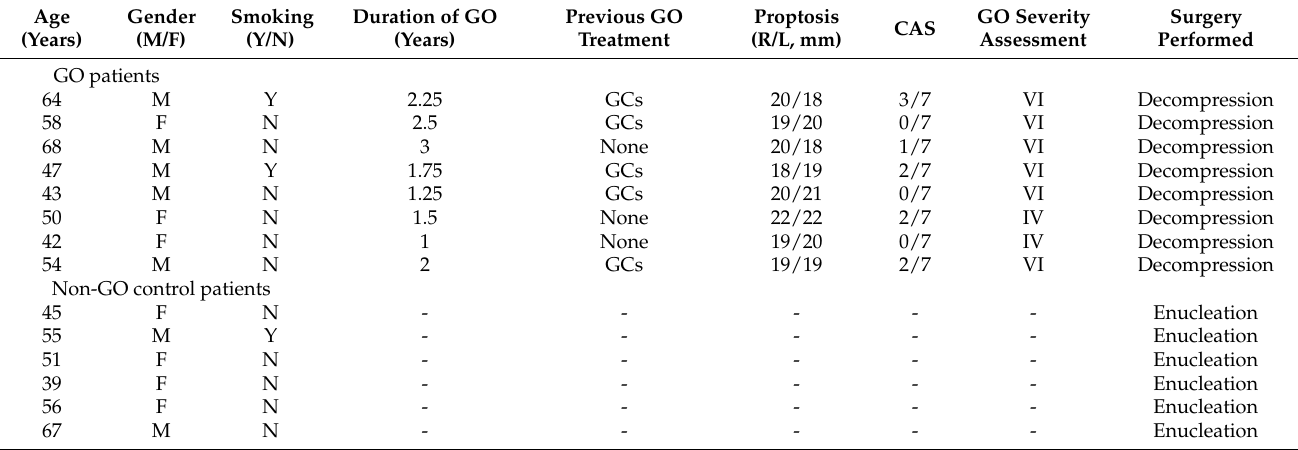
Table 1. Clinical features of patient samples used in this